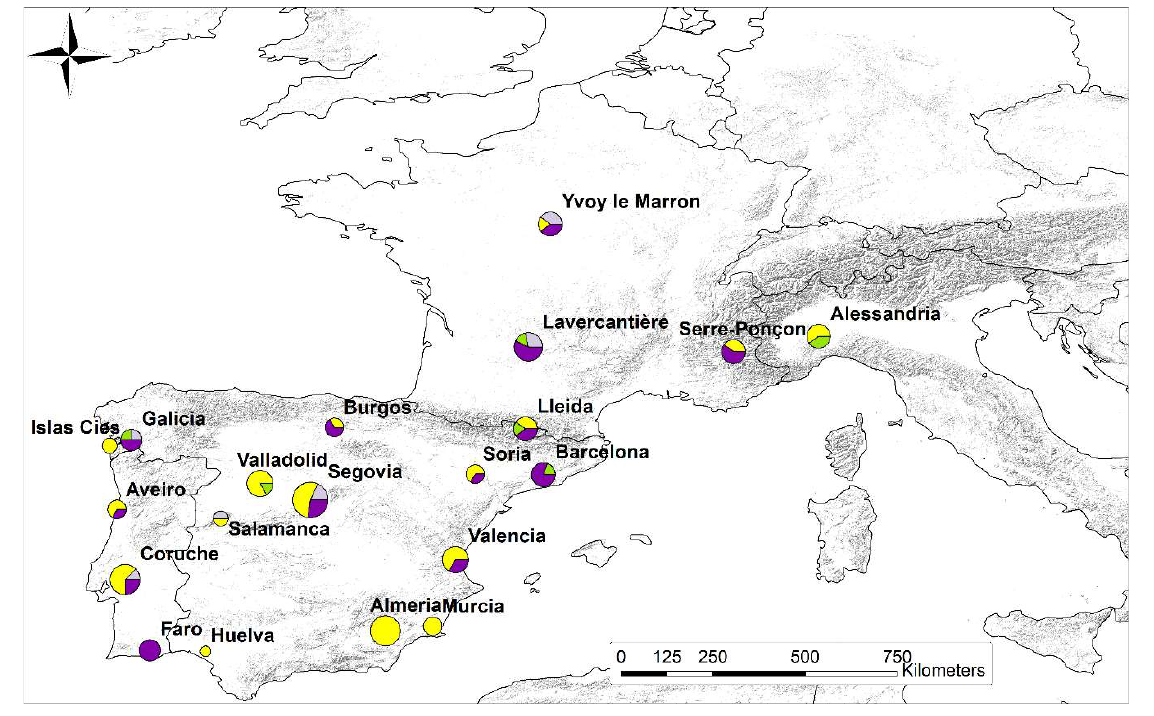
Figure 1. Geographic distribution for Leptoglossus occidentalis populations of the mitochondrial hap- lotypes in Iberian Peninsula, France and Italy, based on the results of the current study and Lesieur et al. [13]. The different colours represent the haplotypes identified by Lesieur et al. [13] with circle size being proportional to the number of individuals. Known years of first observation: 1999: Ales-